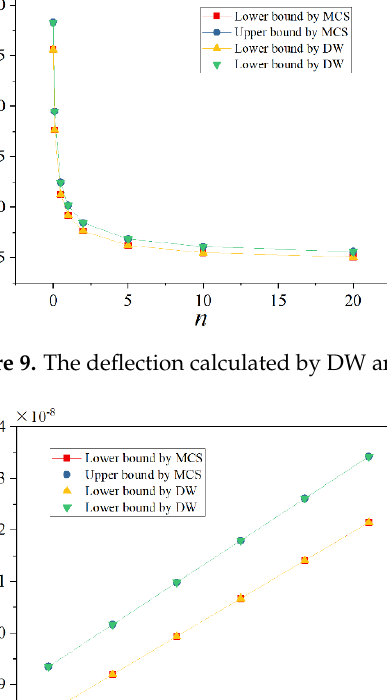
Figure 8. The expectation and standard variance of deflection calculated by PCE and MCS: ( a ) expectation; ( b ) standard variance.